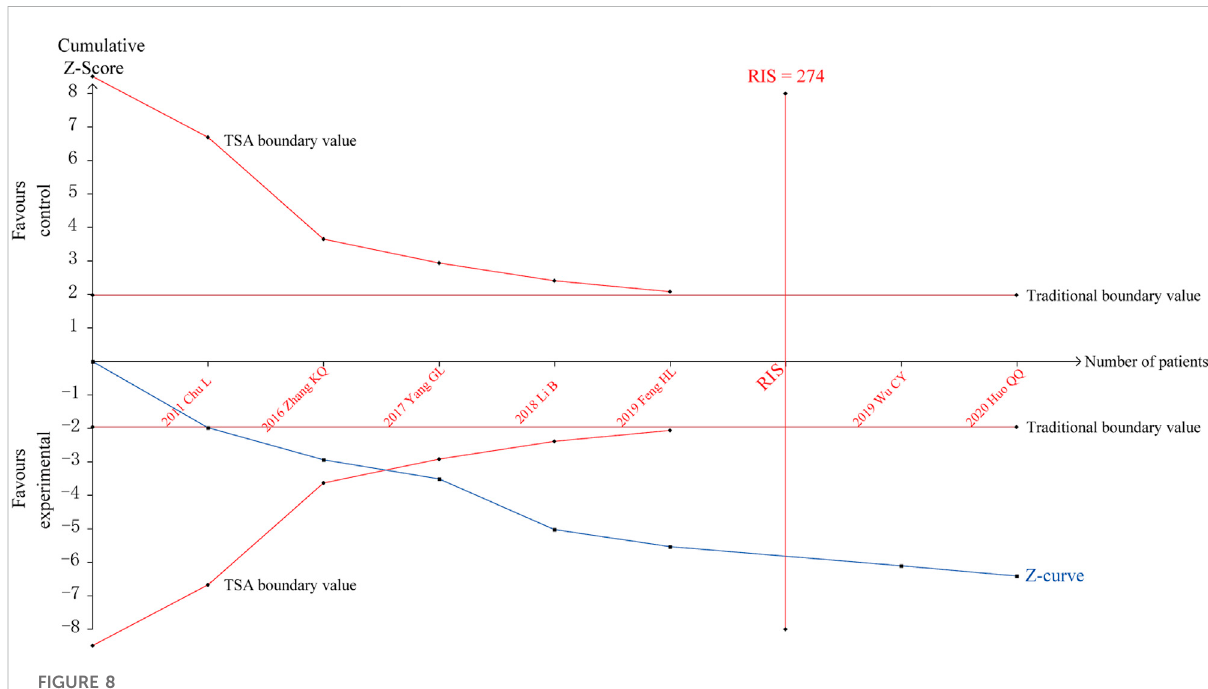
FIGURE 8 Trial sequential analysis for the ef fi cacy on angina